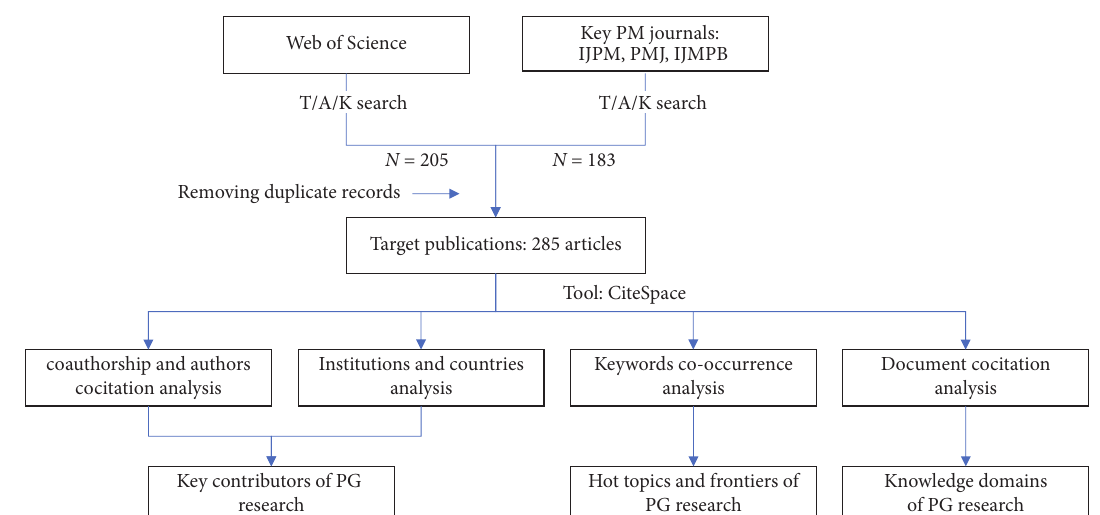
Figure 1: Scientometric review search, selection, and analysis